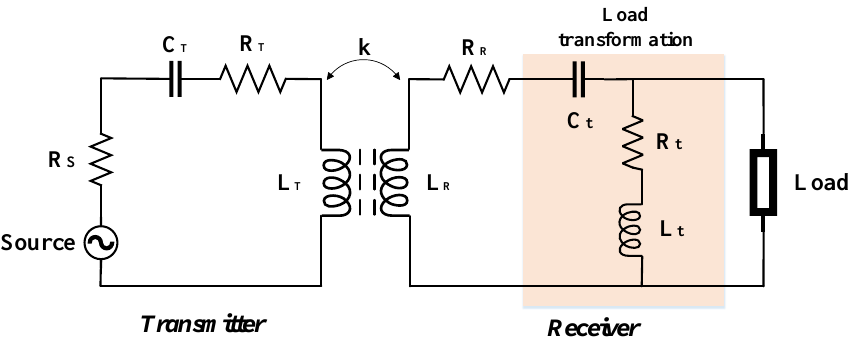
Figure 12. The resonant inductive coupling (RIC) with optimal load